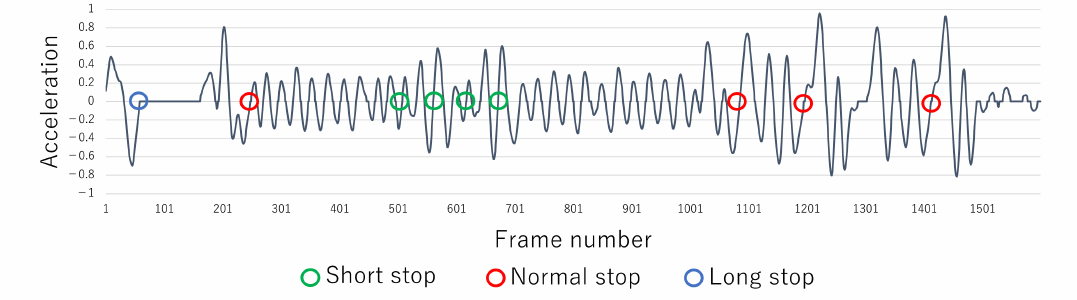
Figure 5. Example of acceleration